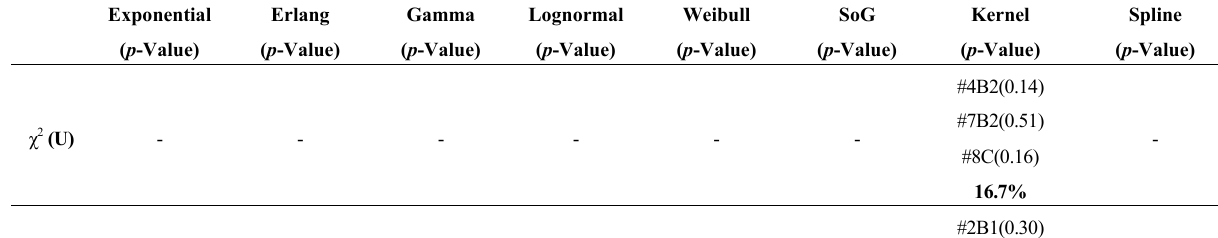
Table 5. Condensed comparative table of non-rejected scenarios for both unprocessed (U) and split (S) scenarios, with parametrical and non-parametrical distributions (the unprocessed part is the same as Table